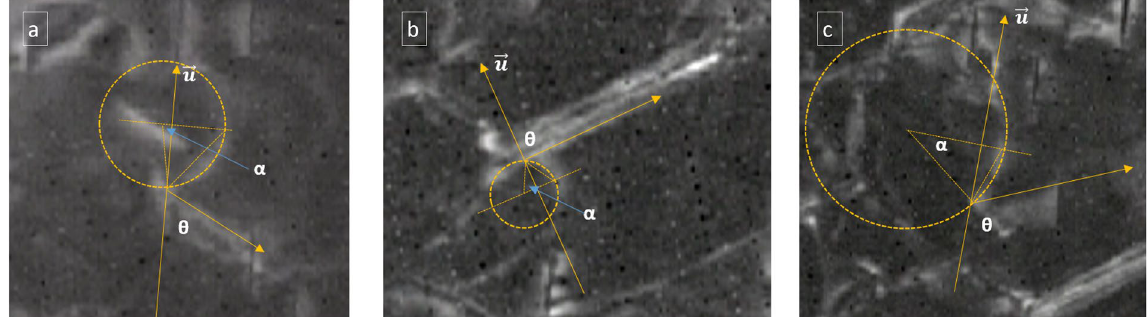
Figure 9. Method for measuring the half central angle for three critical conditions used to determine the